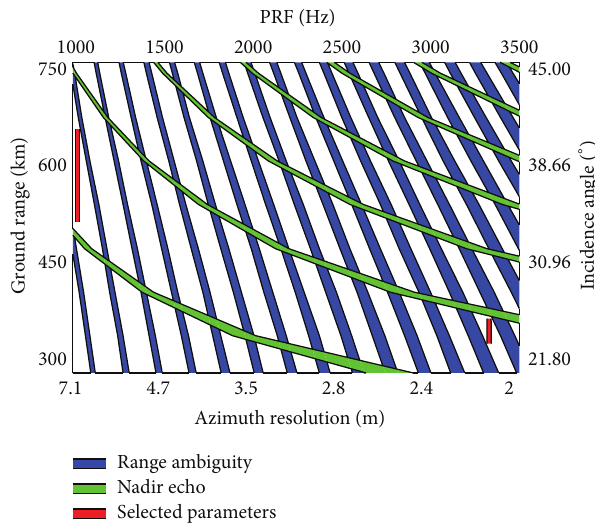
Figure 3: Swath width and azimuth resolution restriction for SAR system design.